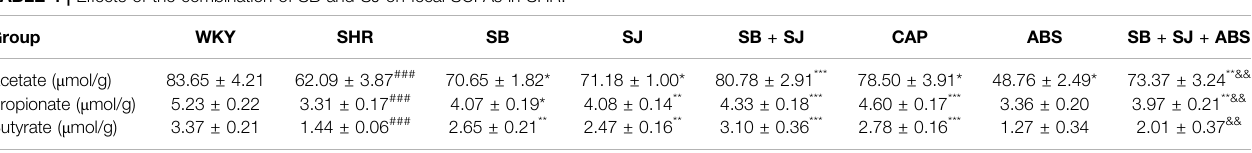
TABLE 4 | Effects of the combination of SB and SJ on fecal SCFAs in SHR.